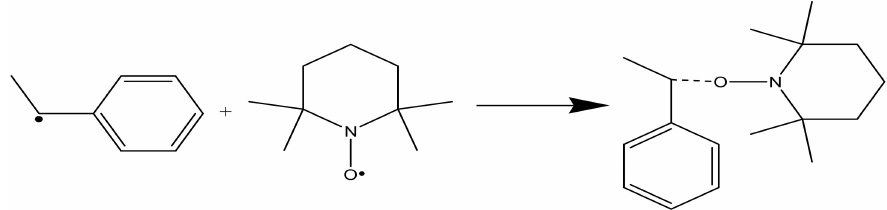
Figure 2. Mechanism of inhibition of styrene polymerization by a typical nitroxide radical. Hydrogen atoms are omitted for